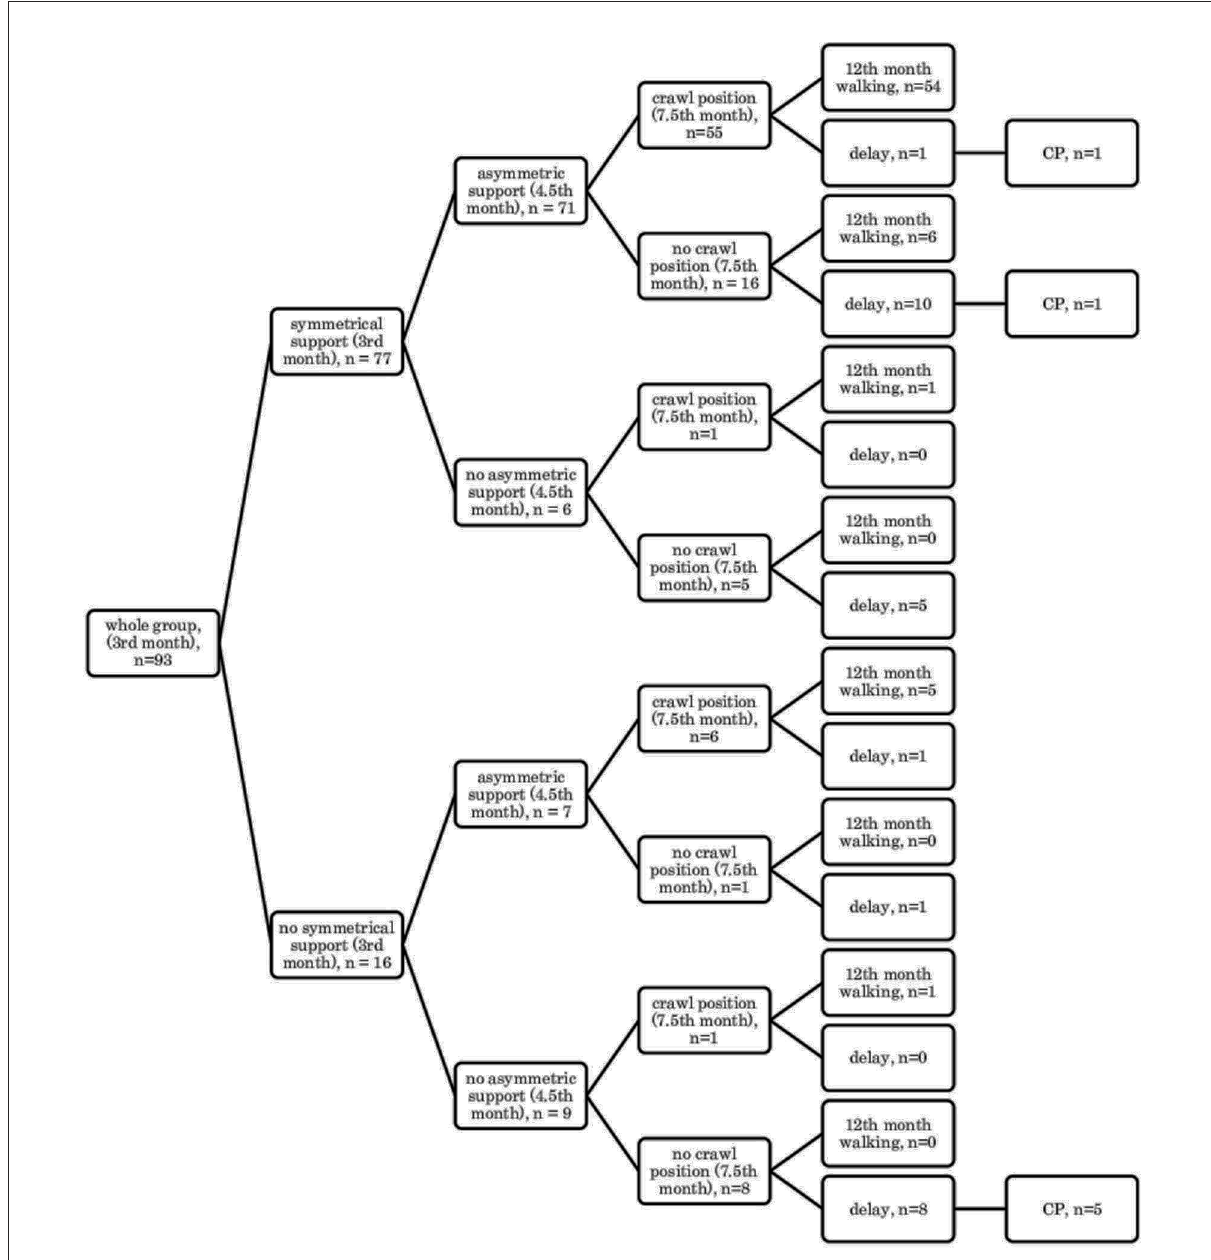
FIGURE4 Motor development in the prone position: symmetrical support (3rd month); asymmetric support (4.5th month); crawl position (7.5th month), and independent walking (12th